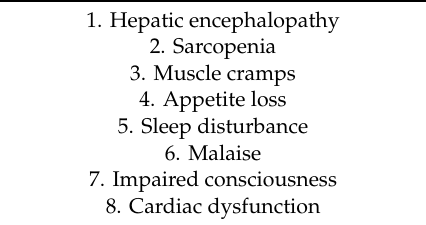
Table 3. Symptoms in cirrhosis patients with carnitine